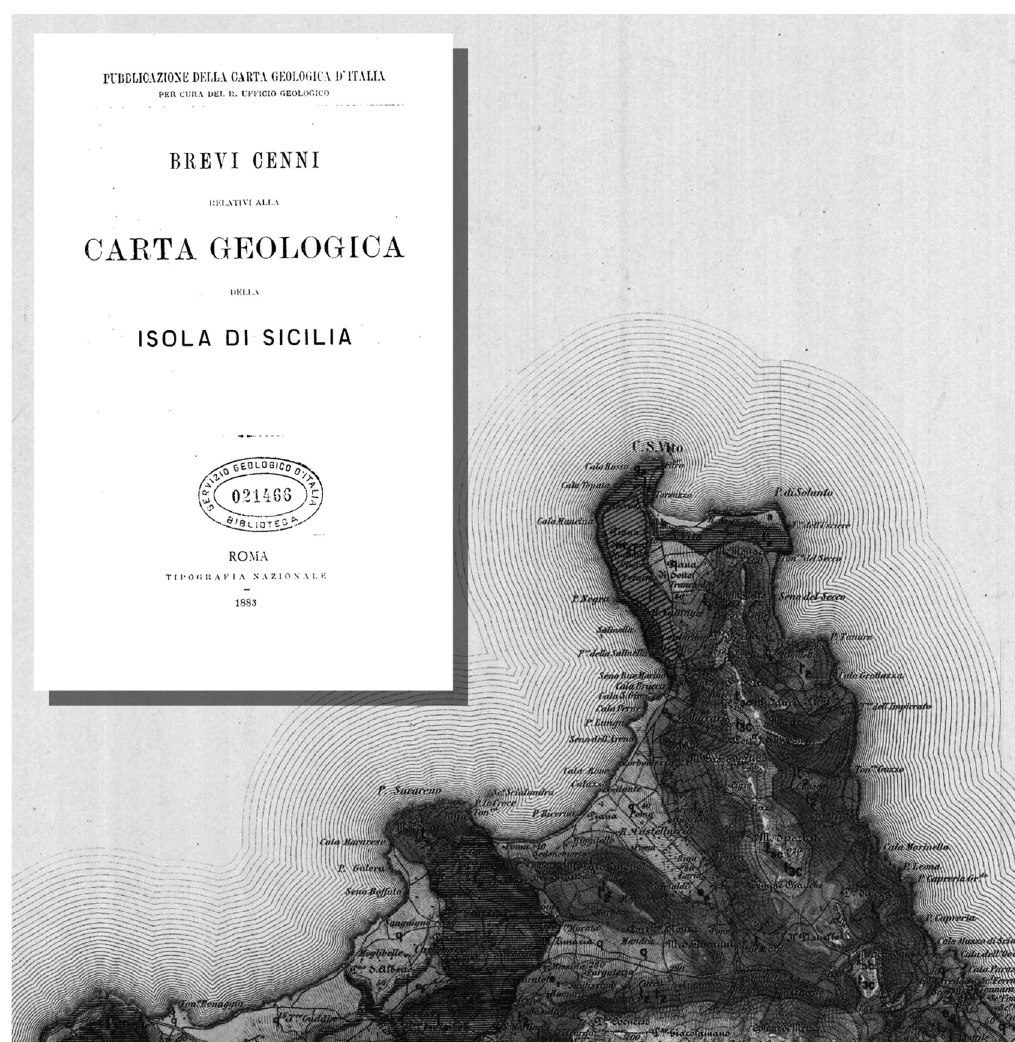
Fig. 5. Extract of one of the first geological maps of Italy published in 1884 (Sheet n. 248 Trapani - Island of Sicily), drafted by the Royal Geological Office. In the box the main page of the «Illustrative